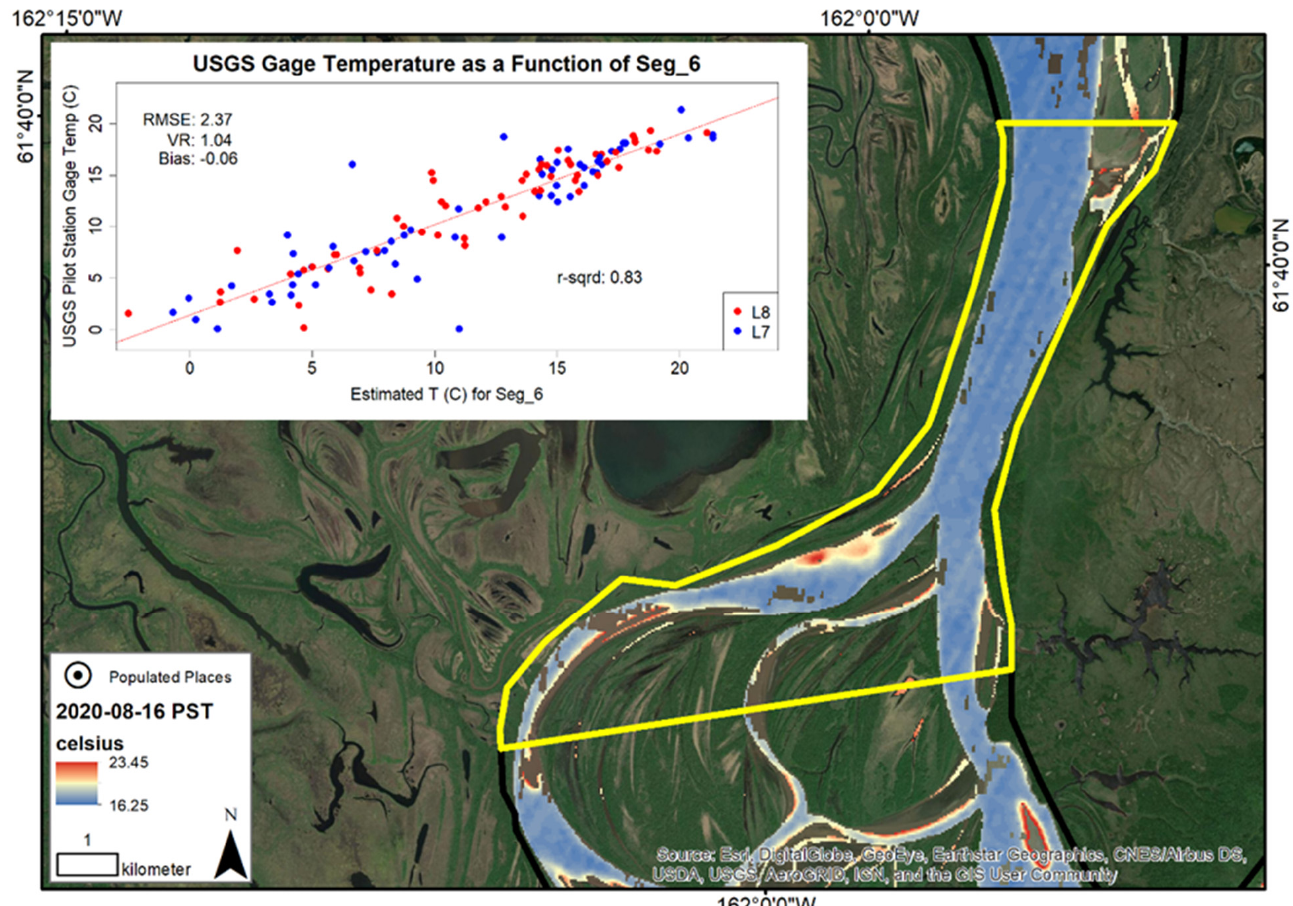
Figure A4. Segment 6 is characterized by the union of three channels (Devil’s Elbow, Middle Slough, Cross Slough, respectively) after passing by large islands. The east shore of the river abuts the rolling uplands of the Ilivit Mountains while the west shore is adjacent to boggy lowlands dissected by lakes, ponds, and creeks. In the scene above, submerged sandbars produce warm water features. At lower stages, these areas are characterized as dry land and omitted. At higher stages, they are not visible and appear as even-temperature open water. Multiple, small NoData gaps occur in the Devil’s Elbow channel as the river enters the segment. Water temperature estimation is well correlated in the segment (RMSE = 2.37 °C, r 2 = 0.83).